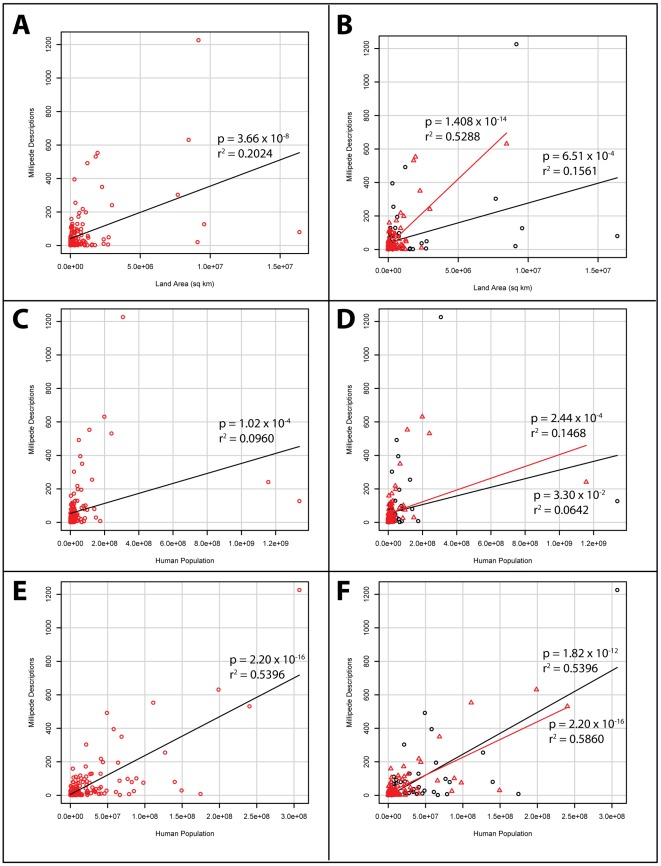
Number of millipede species descriptions in countries as a correlate of land area and human population.Plots A, C, and E show all countries from which millipedes have been described. Plots B, D, and F have the countries designated as tropical (≥50% of total land area in the tropics) or nontropical (<50% of total land area in the tropics) and were analyzed separately. The outliers for human population, India and China, are excluded from plots E and F.